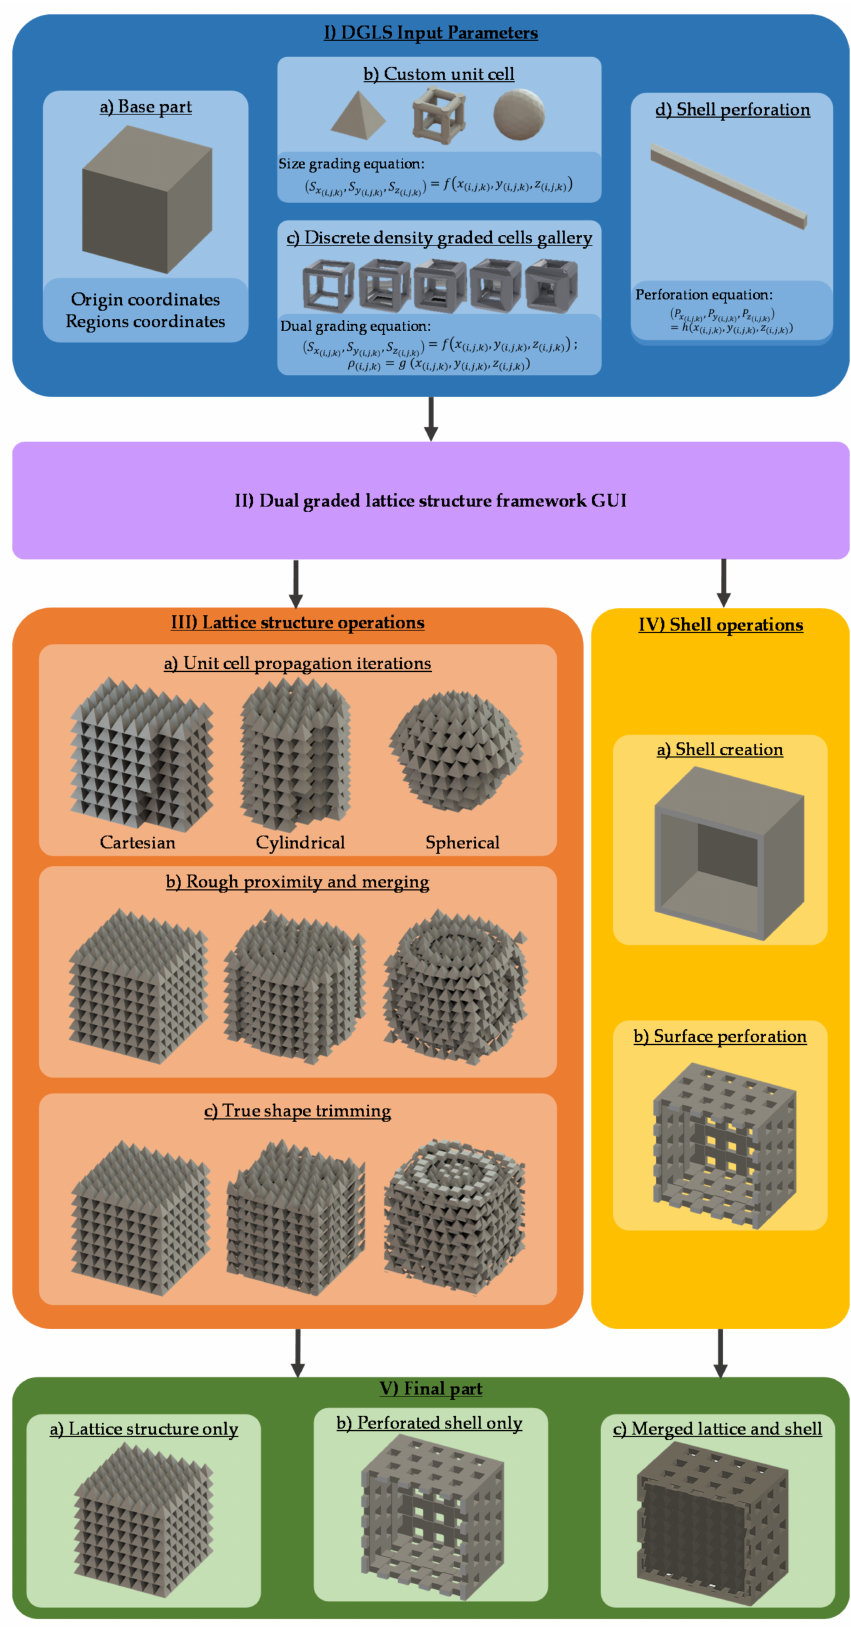
Figure 2. Dual grading generation framework: ( I ) Input files and parameters, ( II ) graphical user interface, ( III ) lattice structure operations, ( IV ) shell operations, and ( V ) final